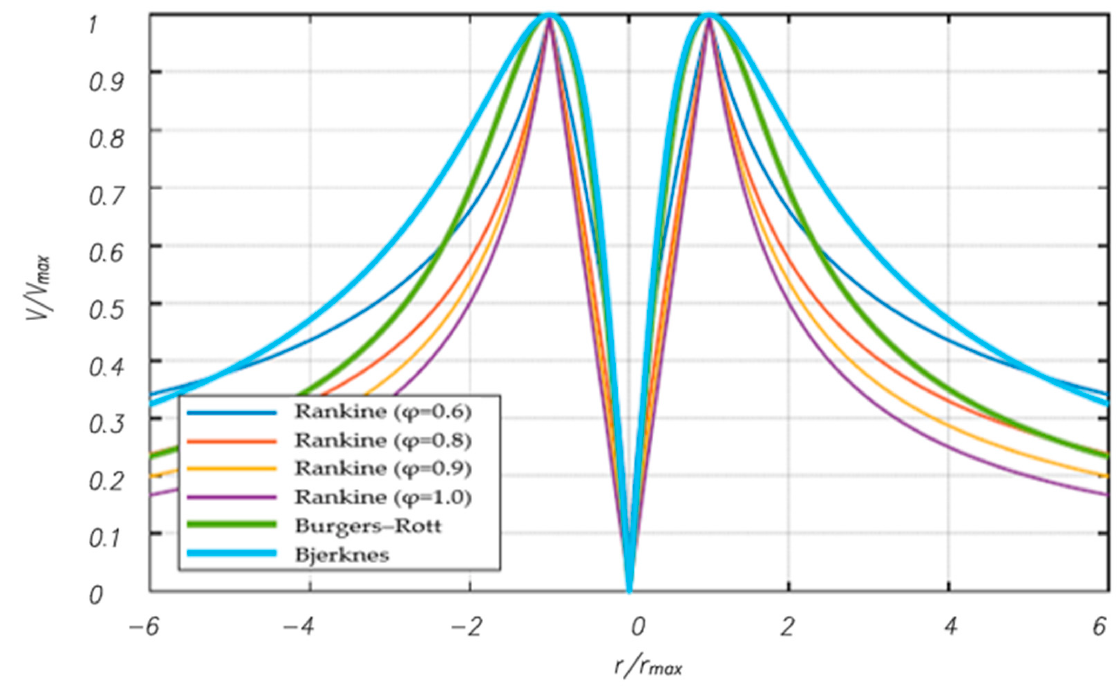
Figure 1. Model of tangential velocity.